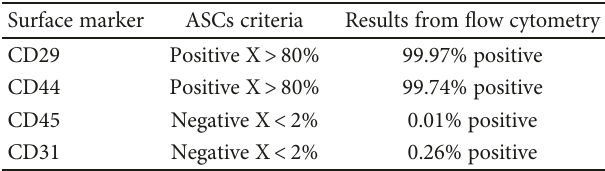
Figure 2: Immunophenotype of cells isolated from SVF conducted to be oADSCs. A gating of cells was based on FSC and SSC criteria, and the cells were subgated to only include single cells and only live cells were measured by fi xable viability dye eFluor 506 staining and used subsequent analysis (data not shown). (a) CD45-negative cells were subgated to analyze the expression of (b) CD44 and CD29 and (c) CD31 and CD29. All quadrants were placed based on the isotype controls. Table 1: Immunophenotypic